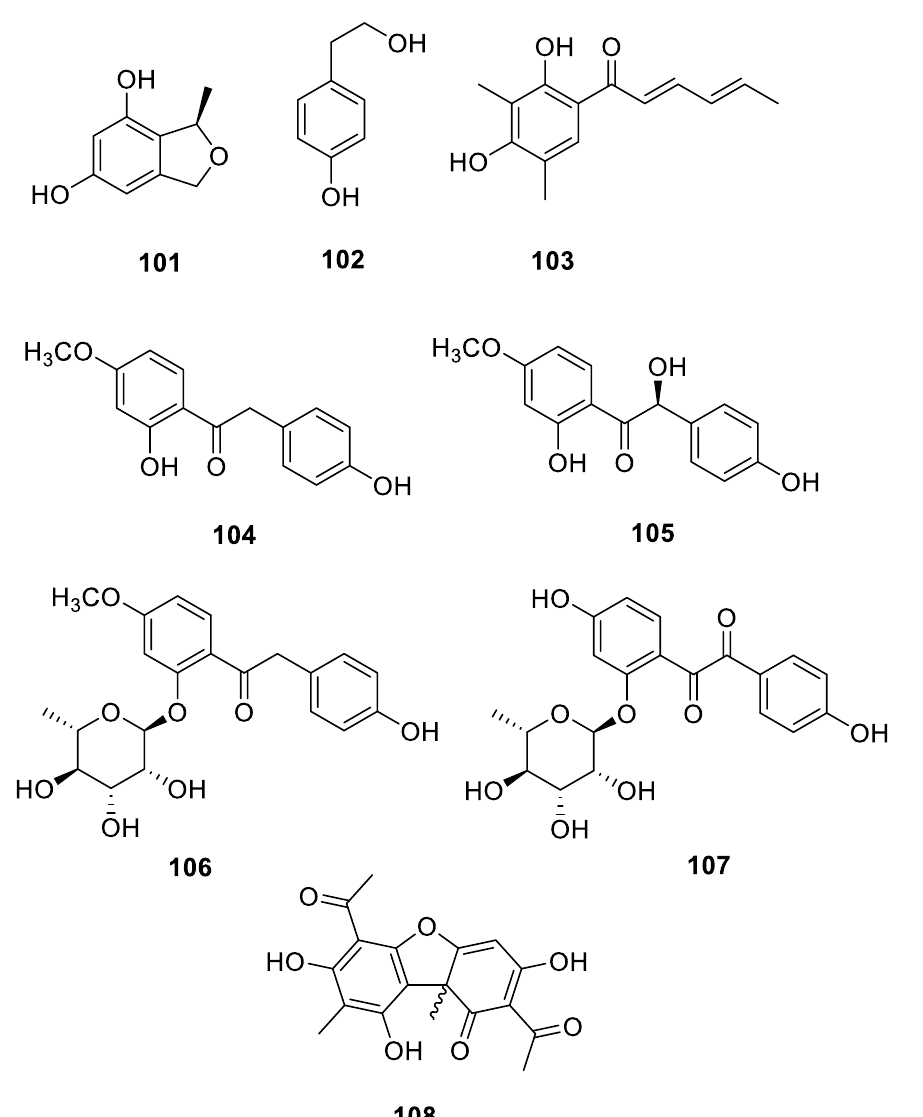
Figure 12. Chemical structures of compounds 101 − 108 from lichen-associated actinomycetota.